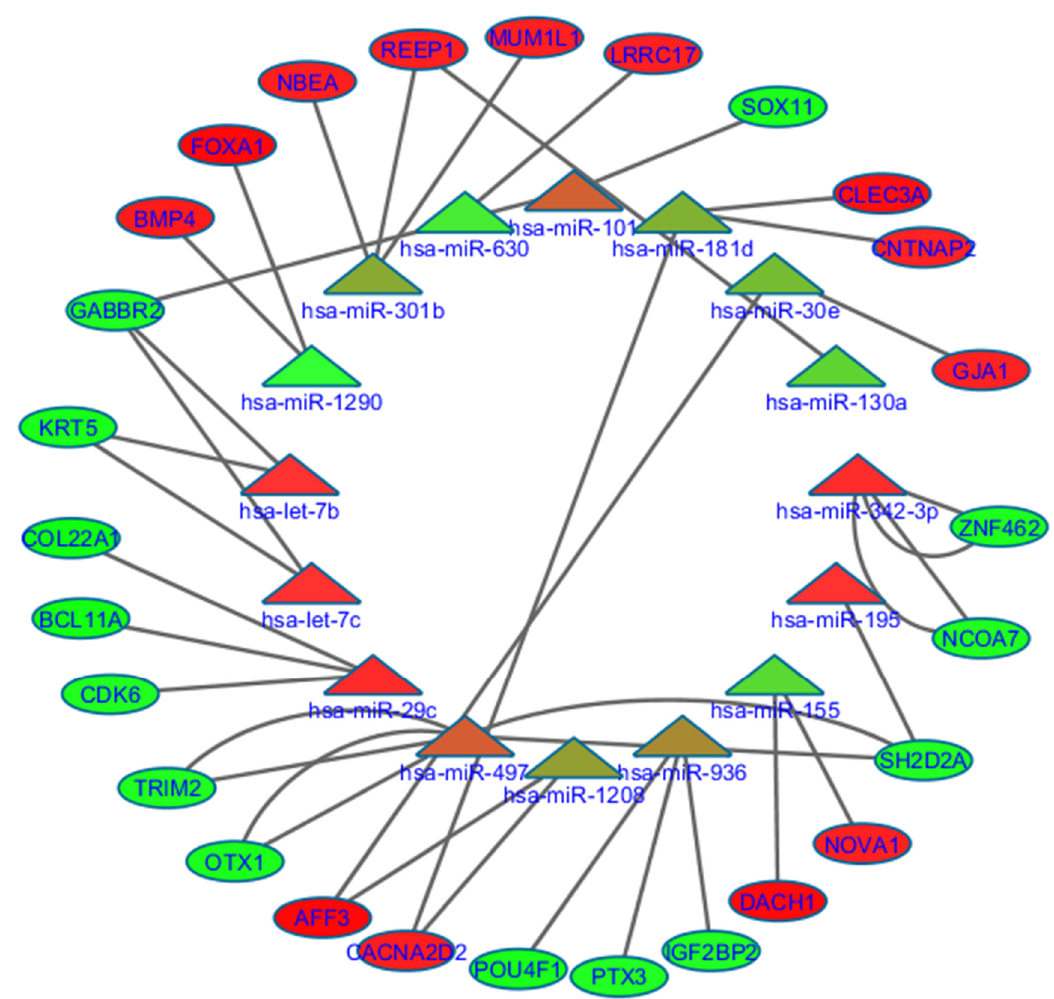
Figure 3. miRNA–mRNA interaction network showing the inverse correlative impact of miRNA to their respective targeting genes from the mRNA expression dataset. The inner track is 16 miRNAs and the outer track is a consensus gene sets of 27 mRNA genes between di ff erentially expressed mRNA and predicted / validated targets from five databases. The miRNAs / genes in green show significant downregulation and red represent the upregulation of targeting genes.